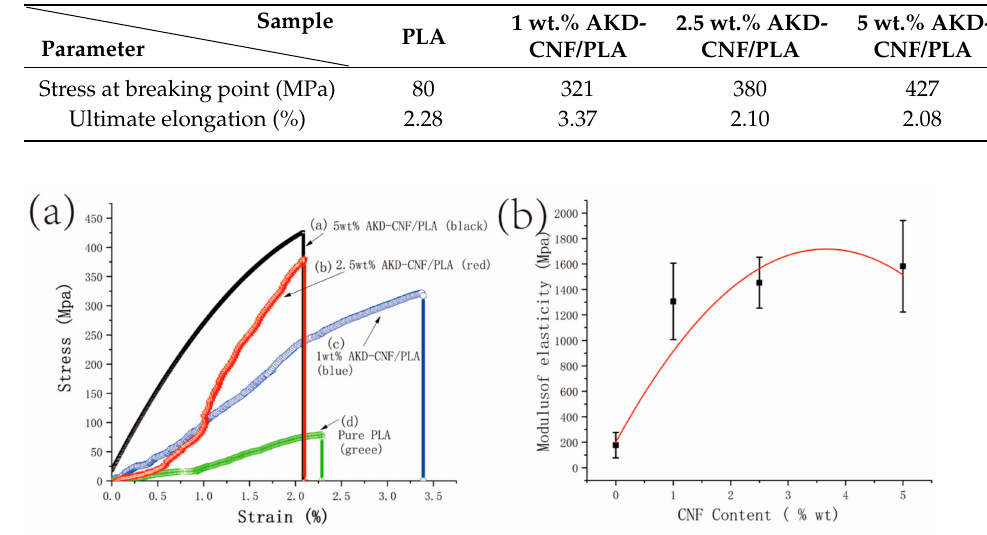
Figure 6. ( a ) Stress–strain curves of the samples of pure PLA (green), 1 wt.% CNF/PLA (blue), 2.5 wt.% CNF/PLA (red) and 5 wt.% CNF/PLA (black) nanocomposites; ( b ) Modulus elasticity- AKD-CNF content relationship